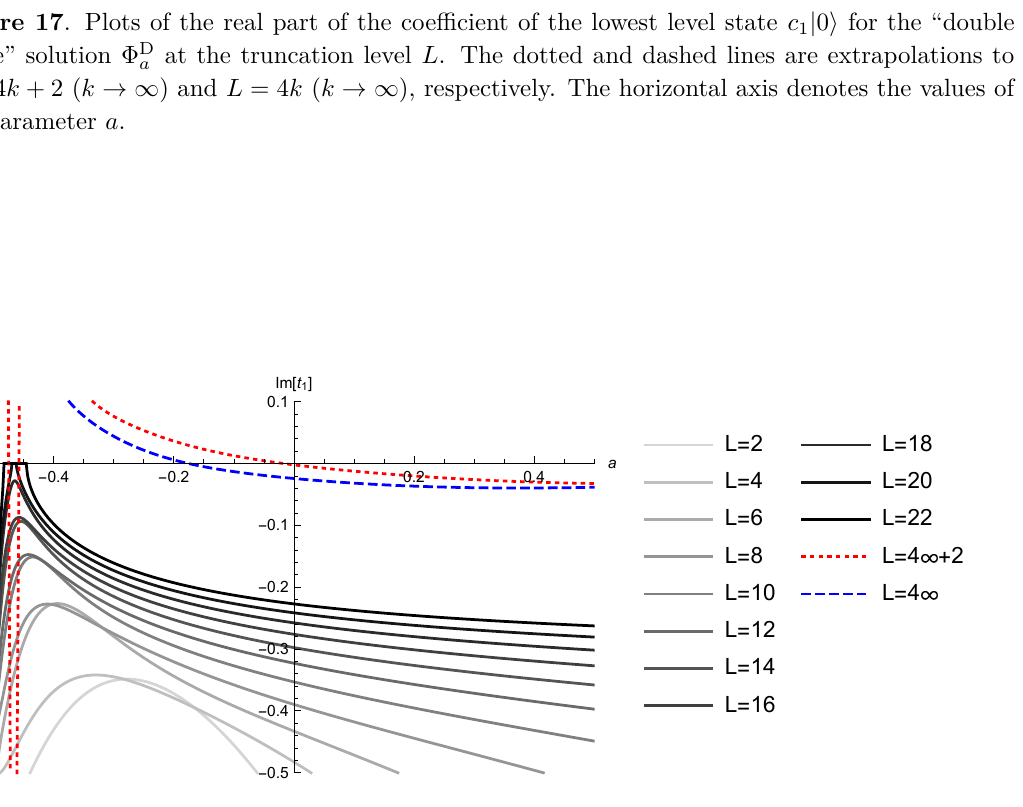
Figure 18 . Plots of the imaginary part of the coefficient of the lowest level state c 1 | 0 i for the “double brane” solution Φ D at the truncation level L . The dotted and dashed lines are extrapolations to a L = 4 k + 2 ( k → ∞ ) and L = 4 k ( k → ∞ ), respectively. The horizontal axis denotes the values of the parameter a